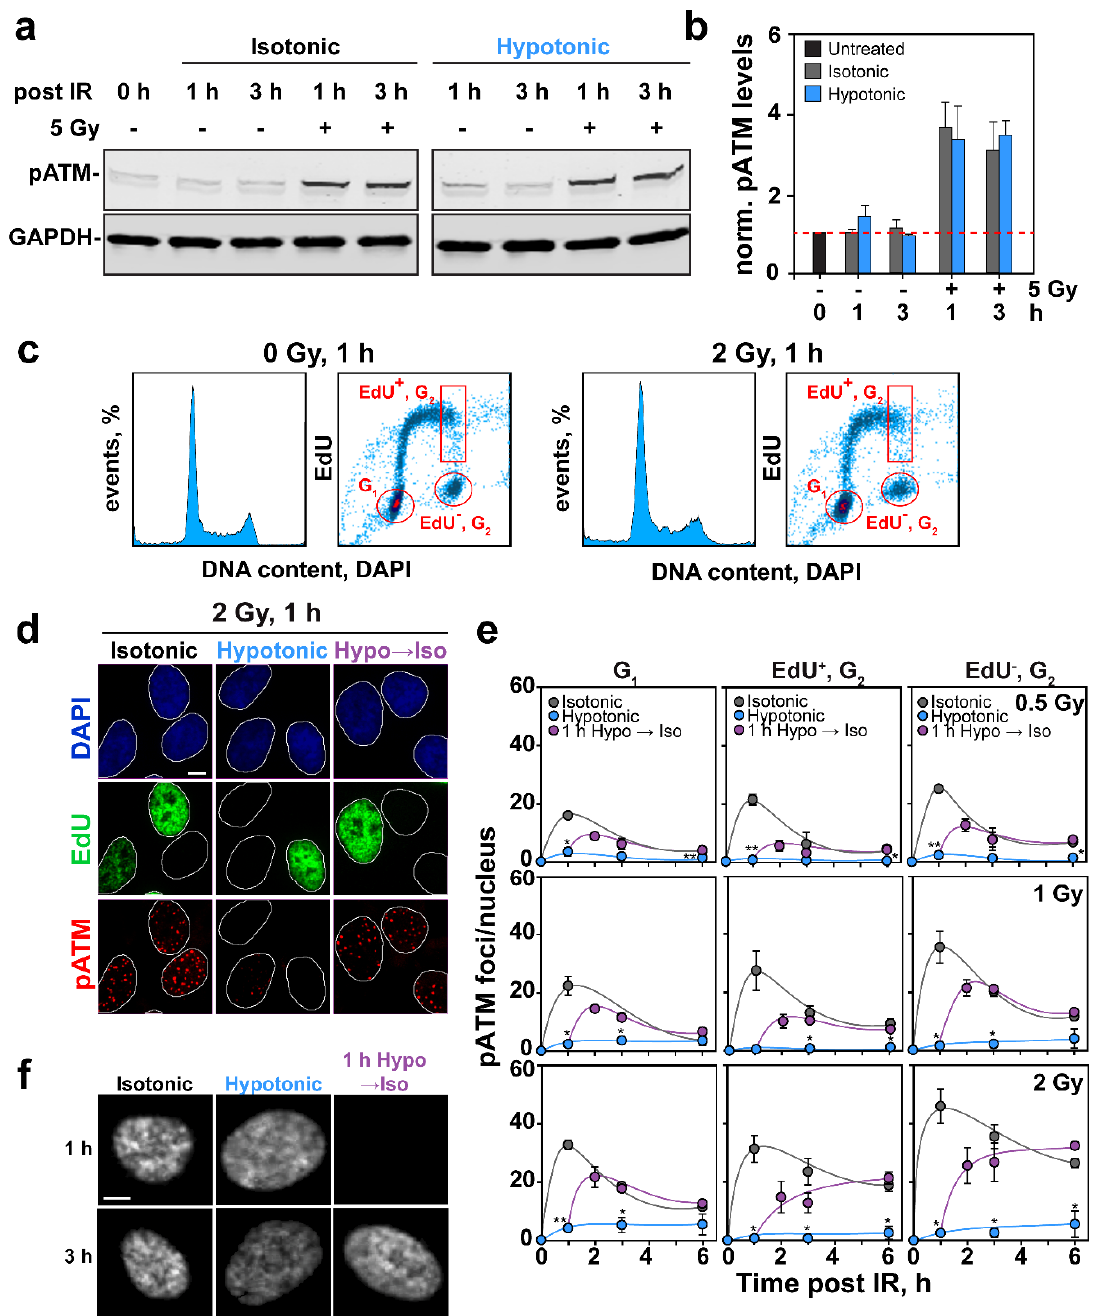
Figure 3. Normal ATM activation but suppressed pATM foci formation after IR in HypoS exposed cells. ( a ) Western blot analysis of pATM in RPE cell extracts as a function of time after irradiation (5 Gy) and incubation in isotonic or hypotonic medium as indicated. GAPDH served as loading control. ( b ) Densitometric analysis of pATM band intensity in a. Plotted is protein level normalized to loading control. Mean ± SE is calculated from three independent experiments. ( c ) Representative histograms and dot plots depicting the gating employed to analyze pATM foci by quantitative image-based cytometry (QIBC) in EdU − , G 2 -phase cells. ( d ) Representative images of DAPI-stained RPE nuclei showing EdU incorporation and pATM foci formation at 1 h after 2 Gy in cells exposed to HypoS or maintained in isotonic medium. Results of cells maintained for 1 h in hypotonic medium and analyzed after transferring to isotonic medium are also shown. Scale bar: 5 µm. ( e ) Values of pATM foci formation after background (nonirradiated) subtraction as a function of time, analyzed by QIBC, in G 1 -phase cells, EdU positive (EdU + ), G 2 -phase cells and EdU − , G 2 -phase cells maintained after IR in isotonic (grey symbols) or hypotonic medium (blue symbols). Violet symbols show results of cells treated hypotonically post IR for 1 h and then transferred to isotonic medium. Data represent the mean ± SE from two experiments. Error bars are visible only when larger than the symbols. ( f ) Representative images of DAPI stained RPE nuclei showing chromatin deconden- sation after HypoS (middle) and recondensation after transfer to isotonic medium 1 h later (right). Scale bar: 5 µm.